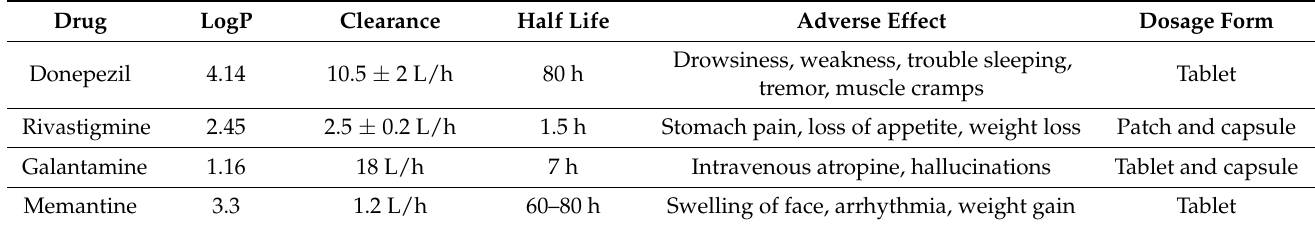
Table 2. Properties of drugs with conventional oral-based